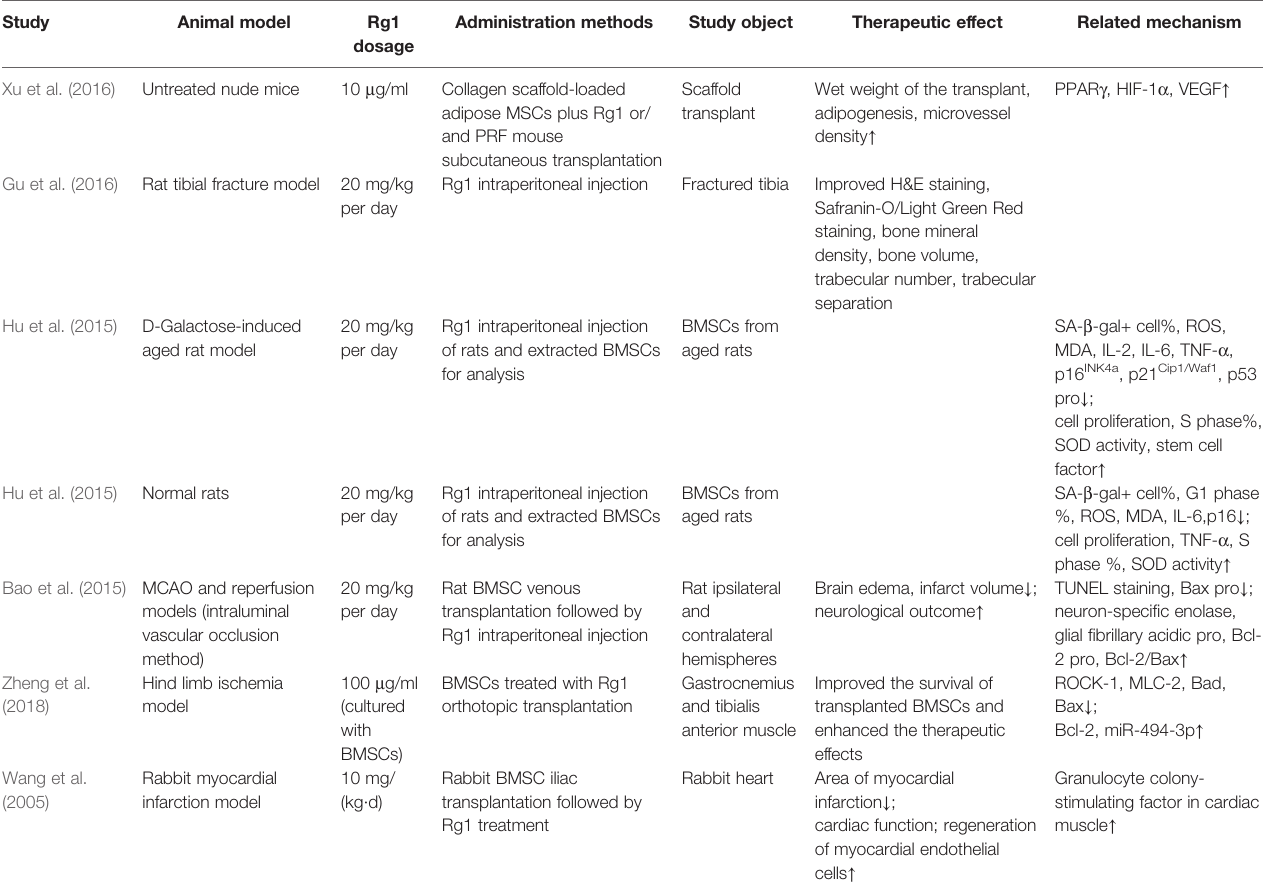
TABLE 4 | Animal experimental studies of ginsenoside Rg1 regulating MSCs in vivo